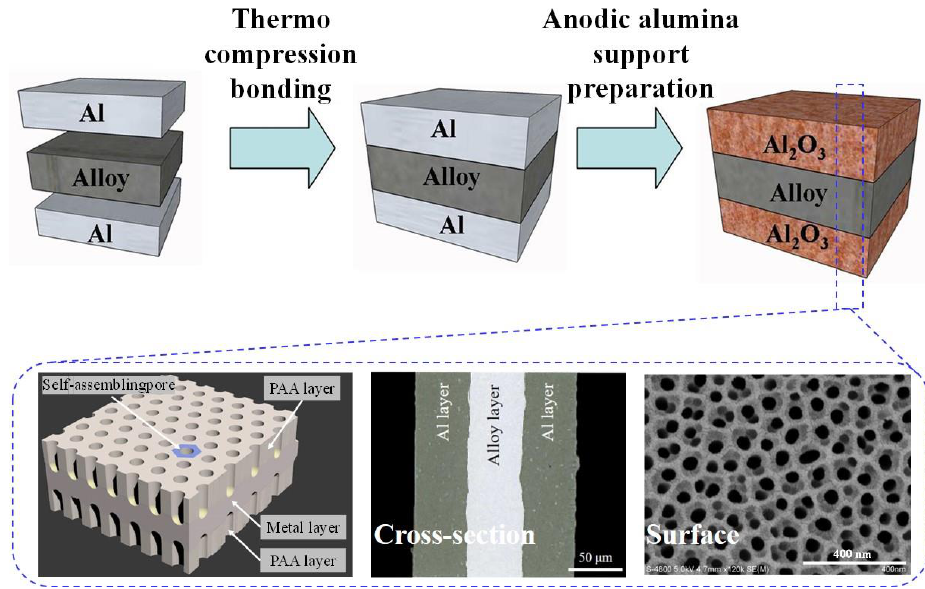
Figure 3. Schematic diagram of the preparation process of anodic alumina support.